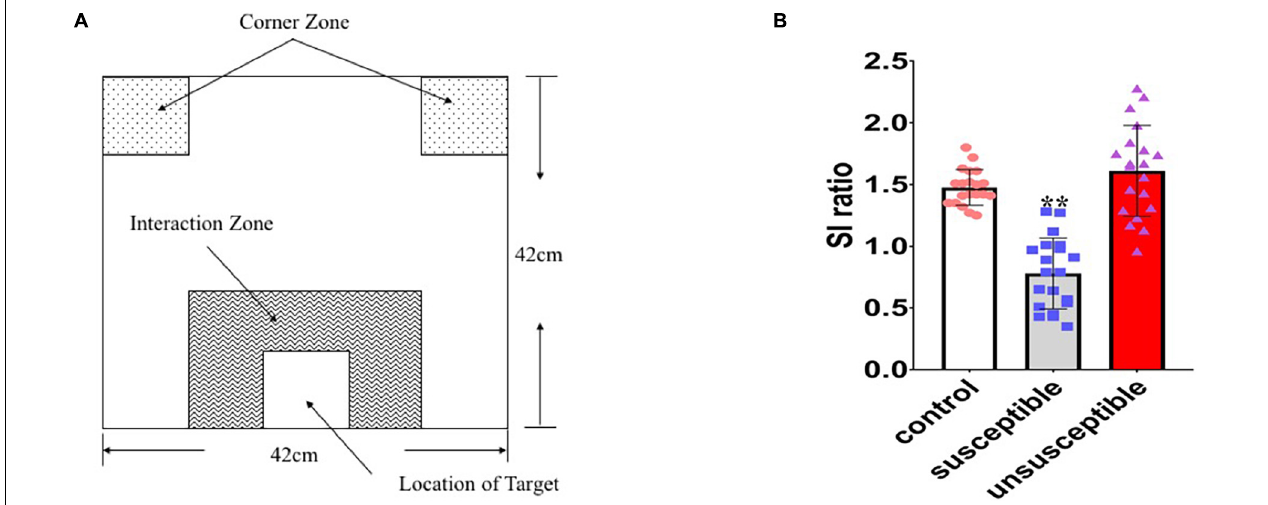
FIGURE 3 | Identification of the susceptible and unsusceptible subgroups. (A) Schematic diagram of the social avoidance arena. (B) Susceptible mice ( n = 20) had lower social interaction ratios than the control ( n = 20) or resilient ( n = 20) mice, indicating social avoidance behavior (F2,57 = 50.11, p < 0.0001).